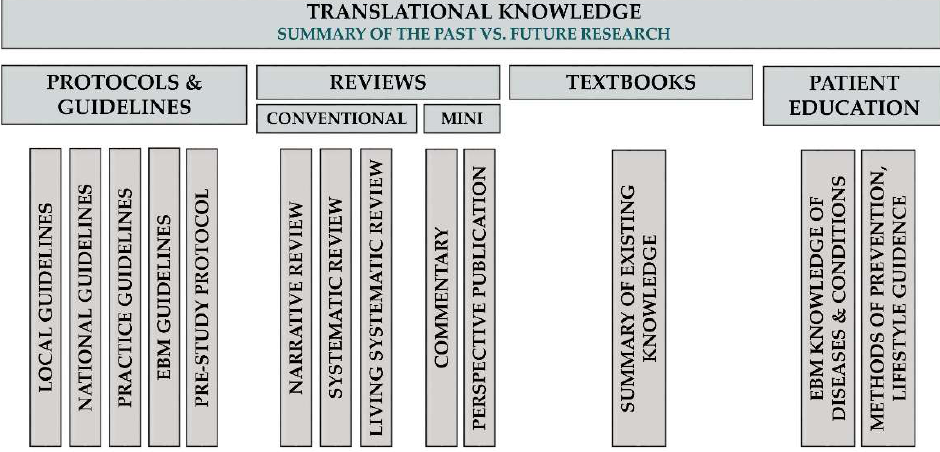
Figure 5. Translational knowledge.